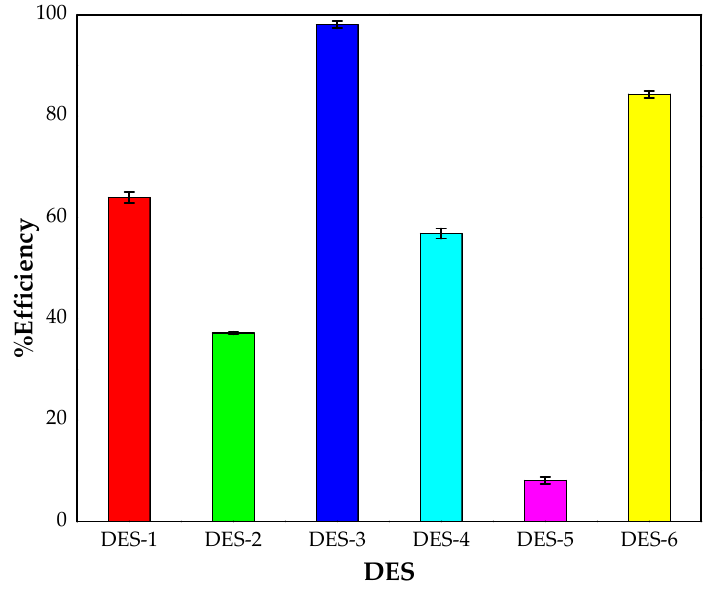
Figure 5. Screening of the synthesized DESs for alizarin extraction (initial concentration of alizarin = 200 mg/L, pH = 6.37, contact time = 5 min, DES dosage = 0.15 mL at 25 ◦ C).